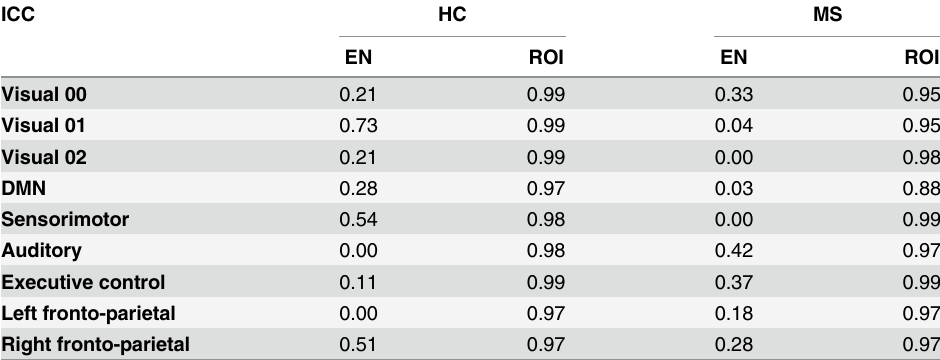
Table 3. Intraclass correlation coefficients (ICCs) of separate networks for HC and patients with MS, for mean of the entire network connectivity (EN) and mean of the ROI connectivity. ICC values of task- related fMRI for HC and patients with MS (hand tapping) as reported by Bosnell et al. (2008), are 0.91 and 0.76,